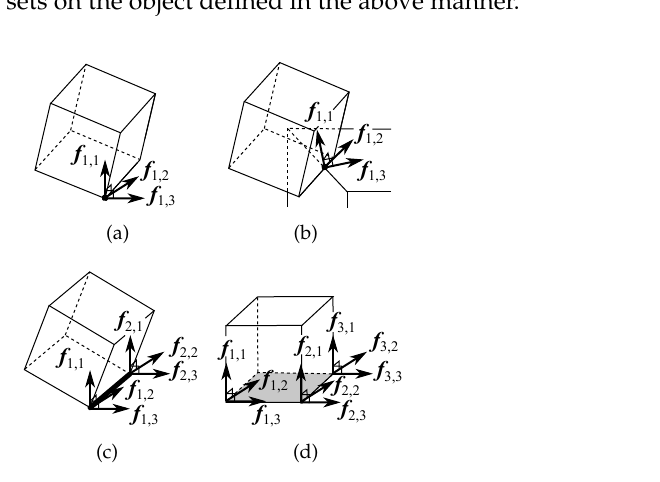
Figure 7. Wrench bases of the force applied on the static contact in the case of ( a ) point–face contact, ( b ) edge–face contact, ( c ) face–face contact, and ( d ) edge–edge–cross